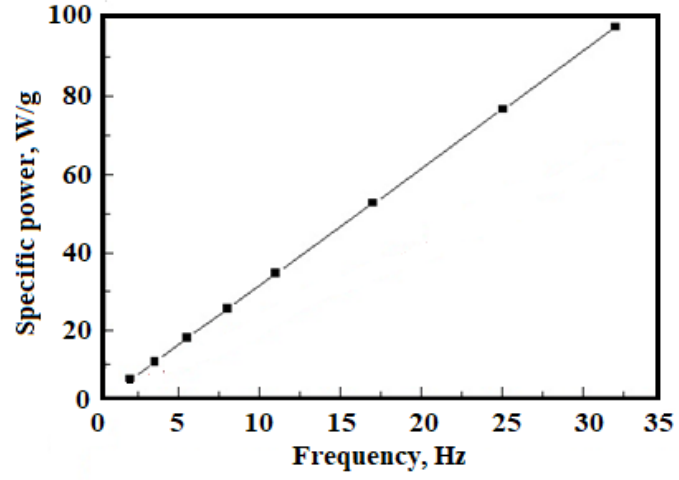
Figure 8. Dependence of the specific power of a working fluid based on a Ti 2 NiCu polycrystalline ribbon on the frequency of external mechanical stress.